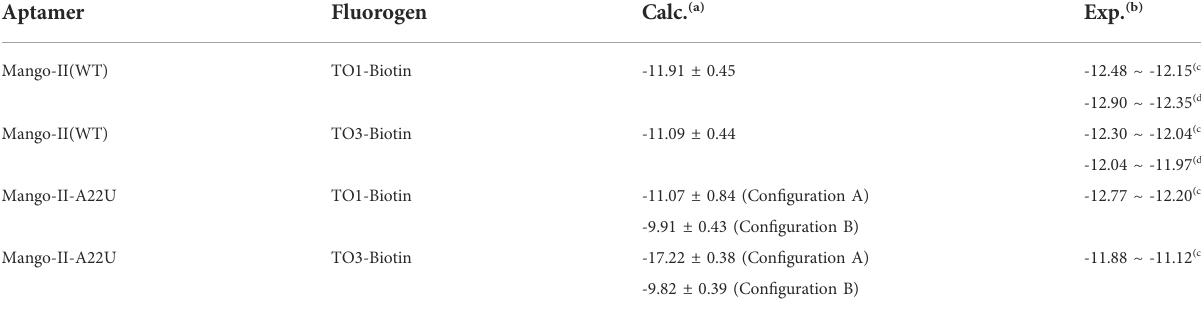
TABLE 2 Calculated and experimental binding free energies between aptamers and fl uorogens (in kcal/mol).